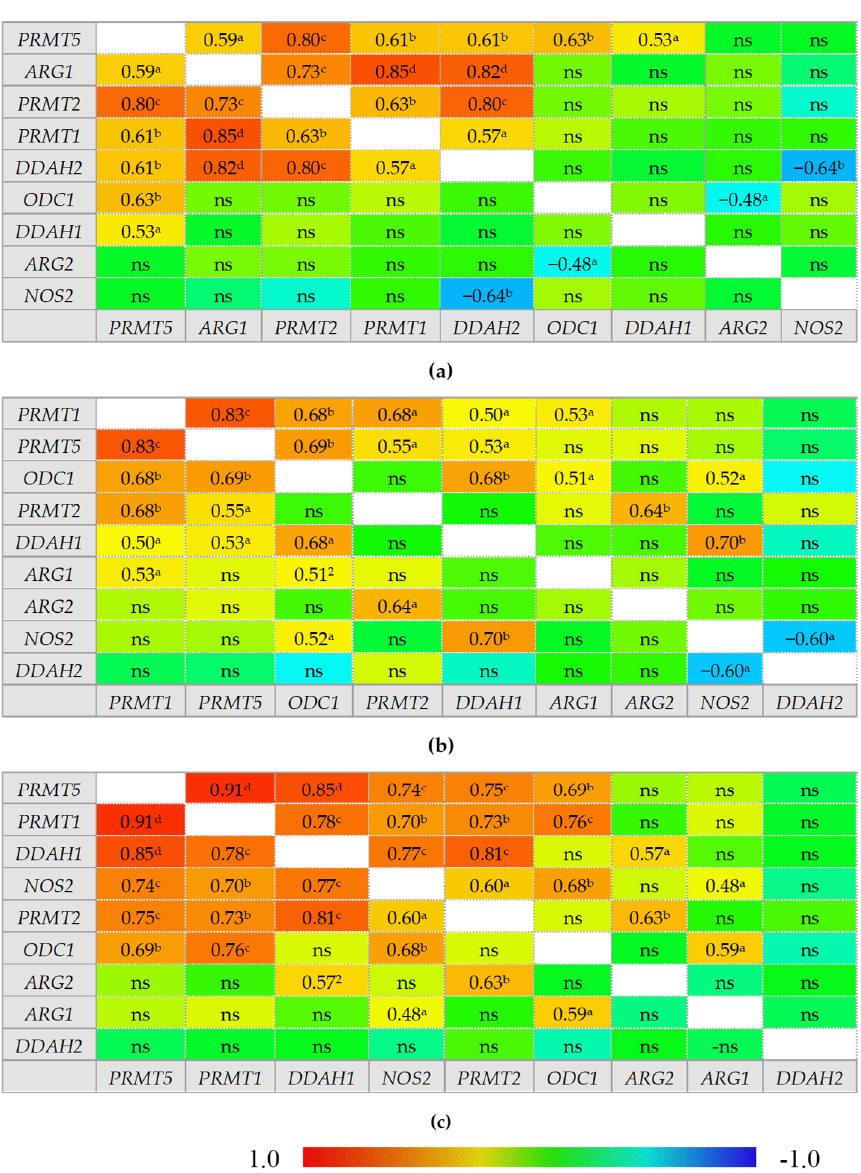
Figure 5. Correlogram for genes encoding L-arginine / NO pathway enzymes: ( a ) in quiescent small bowel from patients with Crohn’s disease; ( b ) in inflamed small bowel from patients with Crohn’s disease; ( c ) in normal small bowel from patients with ulcerative colitis. Results presented as correlation coe ffi cients r and analyzed on log-transformed data using Pearson’s correlation test; a p < 0.05; b p < 0.01; c p < 0.001; d p < 0.0001; ns, non-significant; ARG, arginase; DDAH, dimethylarginine dimethylaminohydrolase, NOS, nitric oxide synthase; ODC, ornithine decarboxylase; PRMT, arginine